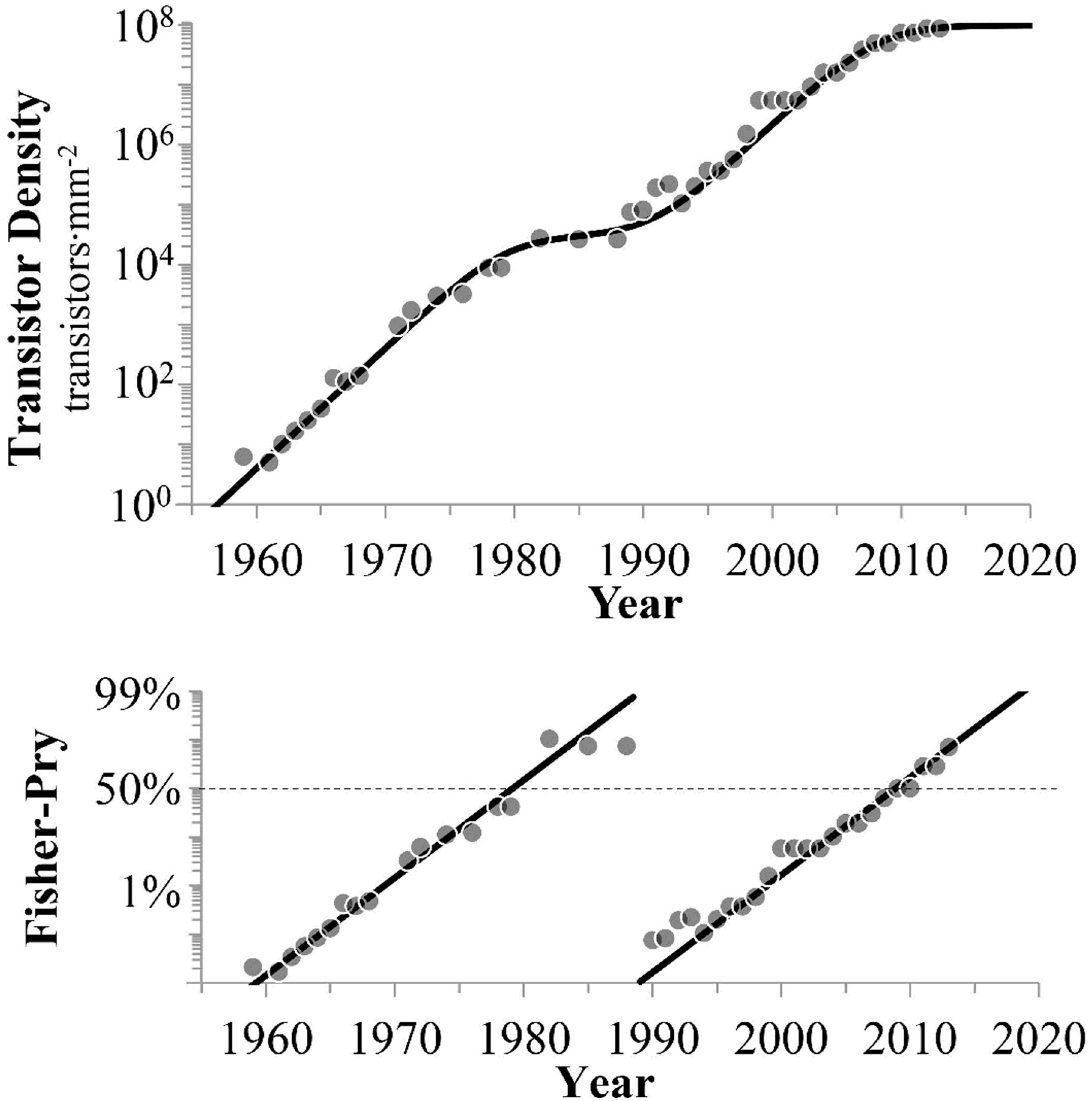
Fig 4. The temporal trend of transistor density. A) The data exhibit a bi-logistic curve. B) Decomposition and linearization of the individual trends are depicted as percent of growth for each of the two phases. Parameter values are shown in Table 2.